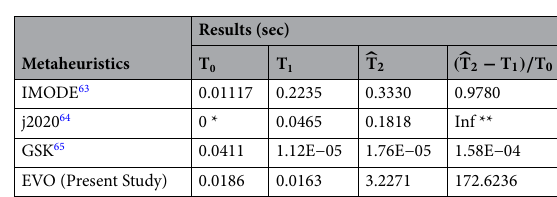
Table 6. The computational time of different algorithms in dealing with the CEC 2020 procedure. *It is a rounded value. **